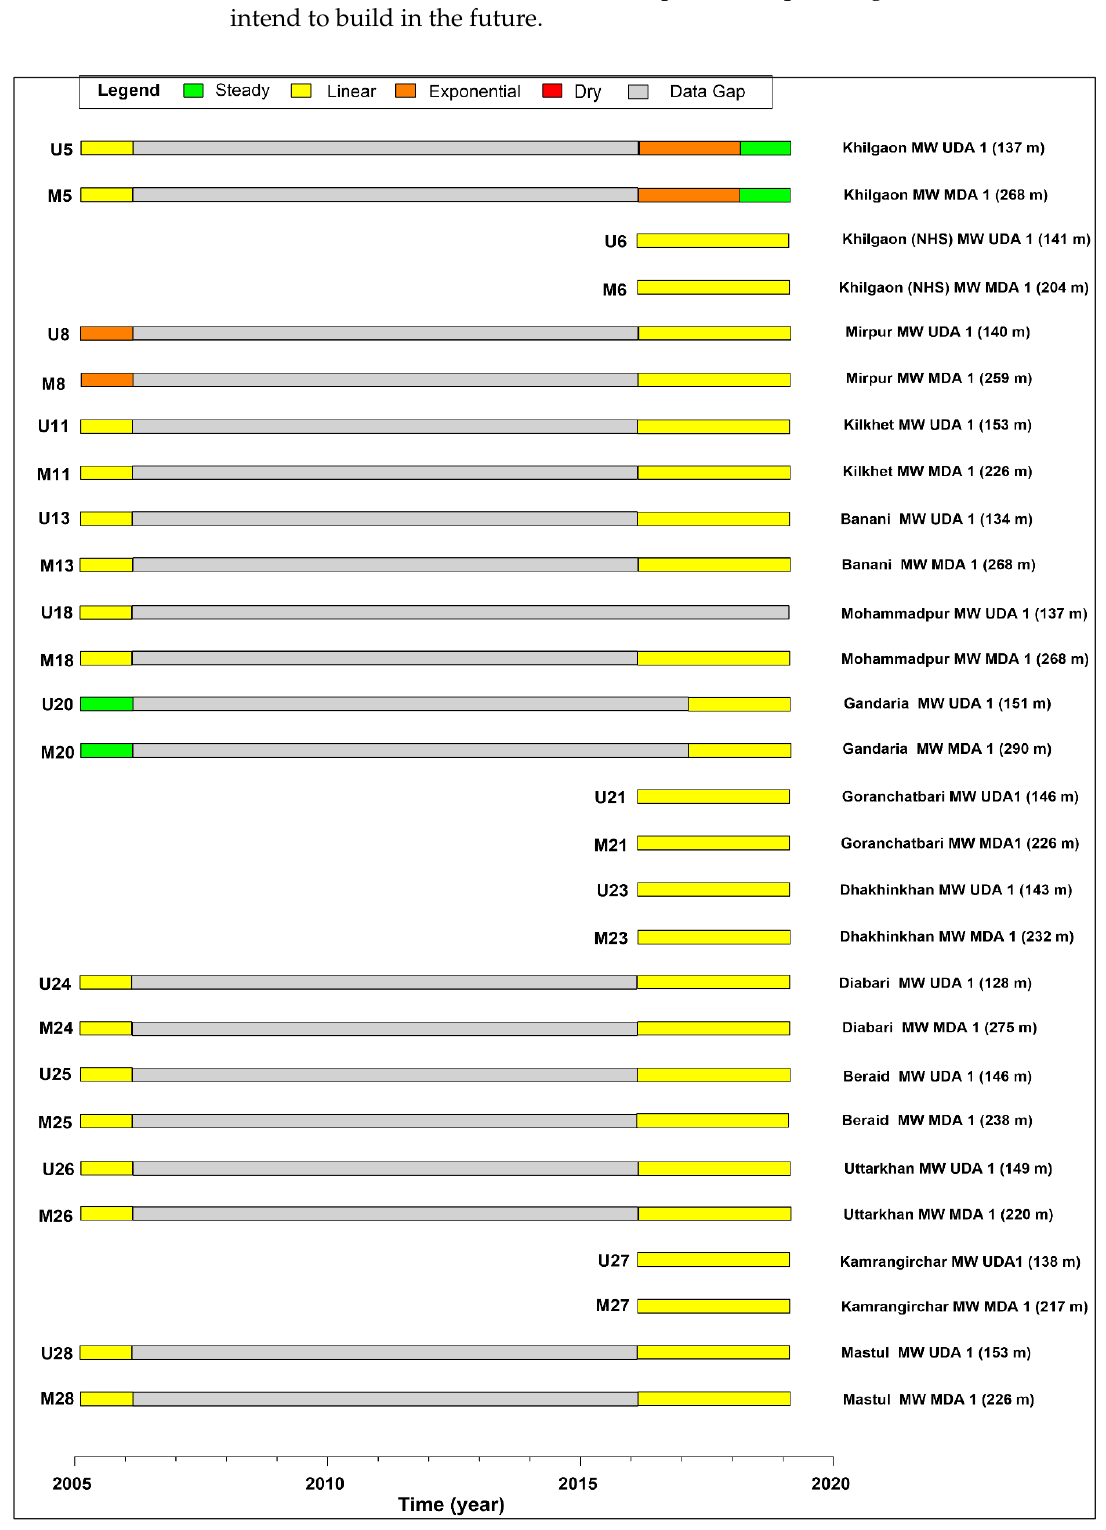
Figure 14. Comparative synthetic graphical overview of piezometric trends of UDA and MDA (twin wells) in Dhaka city. Rise (increasing PL), Steady (no PL trend), Linear (declining PL) and Exponential (increasing PL slope) are used to characterize the hydrograph.